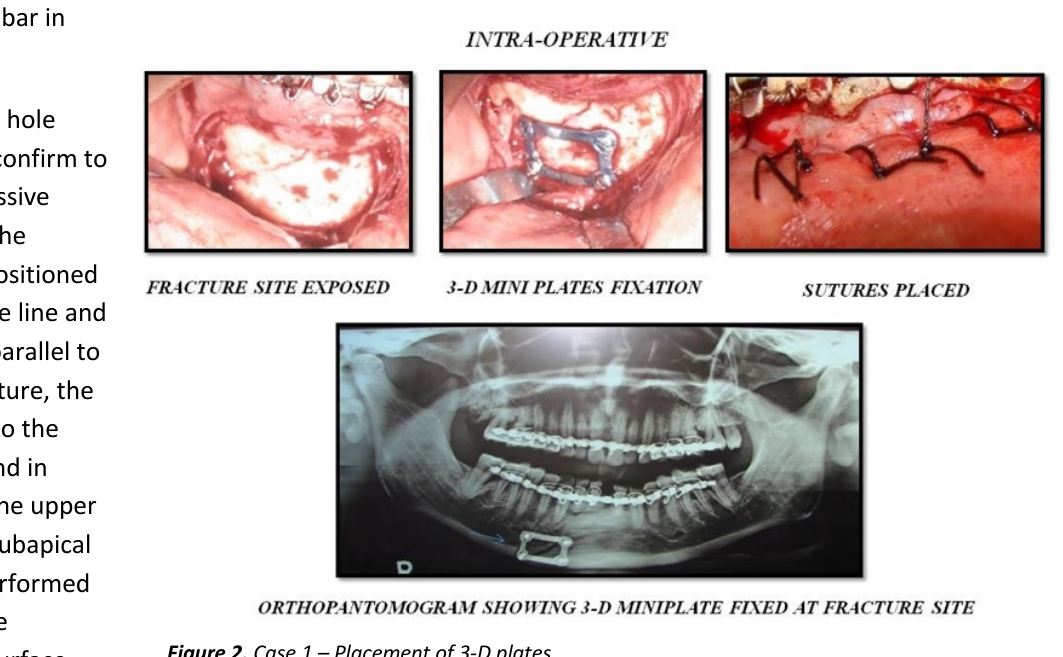
Figure 2. Case 1 – Placement of 3-D